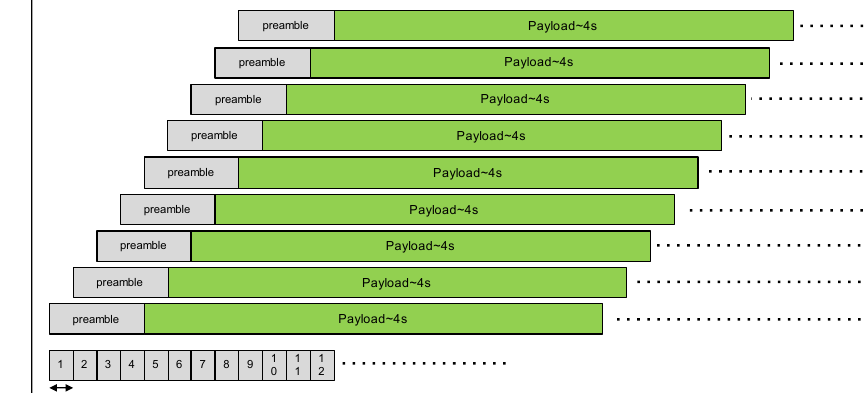
Figure 8. Second CE experimentation, case